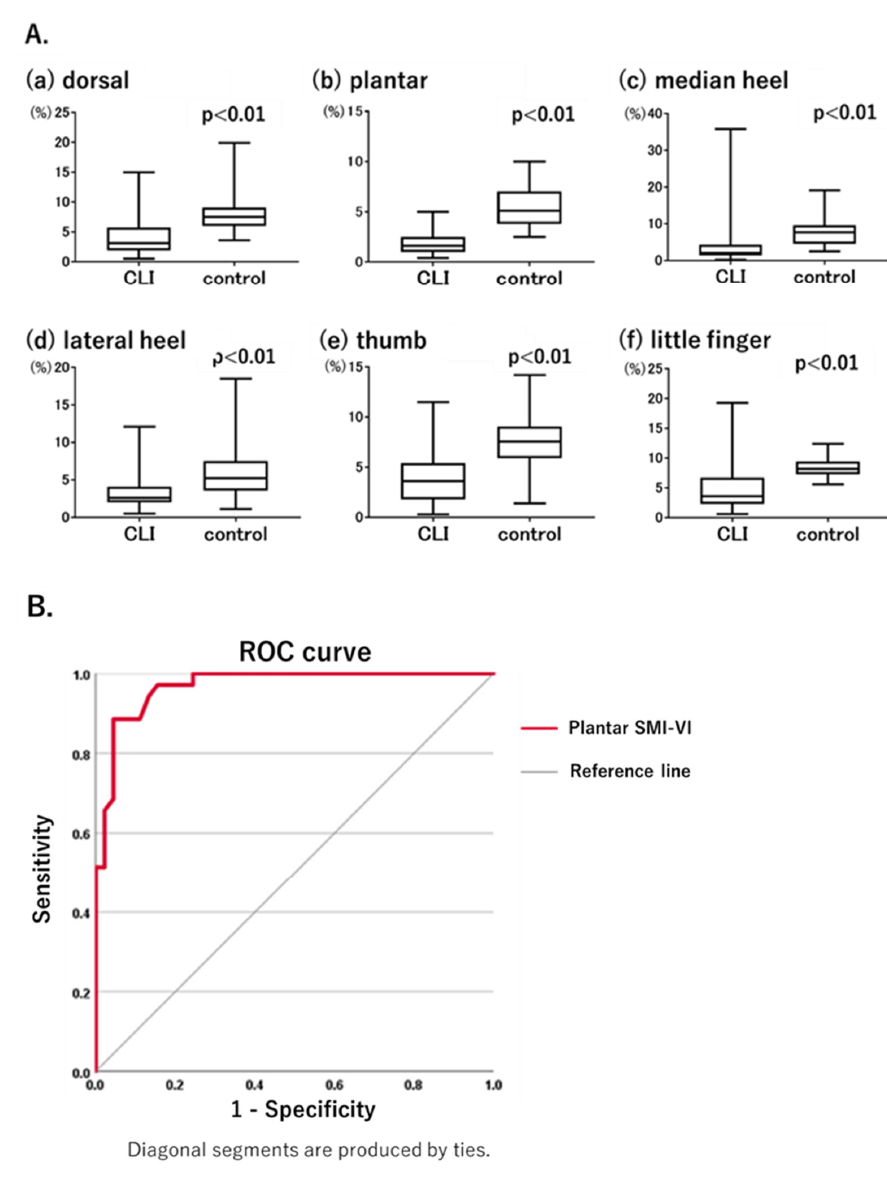
Figure 2. ( A ). Comparison of SMI-VI values between critical limb ischemia (CLI) and control groups. The SMI-VI was significantly lower in the CLI group than in the control group at all measurement points. ( B ). Diagnostic performance of plantar SMI-VI for CLI, as determined using a receiver operating characteristic curve. Area under the receiver operating characteristic curve of 0.969, a sensitivity of 88.6%, and a specificity of